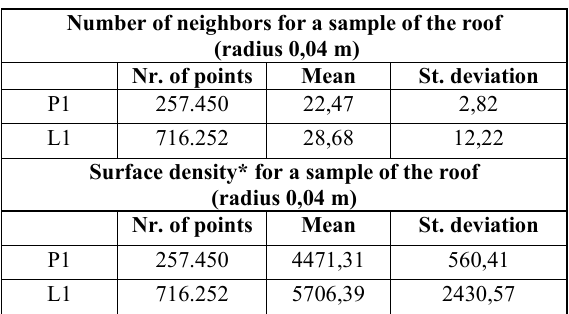
Figure 8. Density analyses of a roof section. The color scale on the right of each image shows the number of neighbors, while the image represents the density visualization. P1 (a) is used as ground reference and L1 (b) as compared dataset.